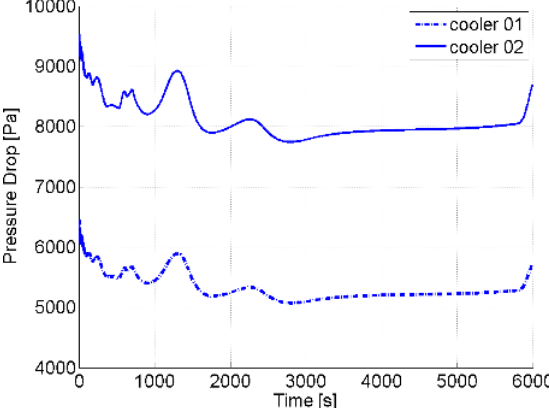
Fig. 10. Pressure drops across the coolers in a course of